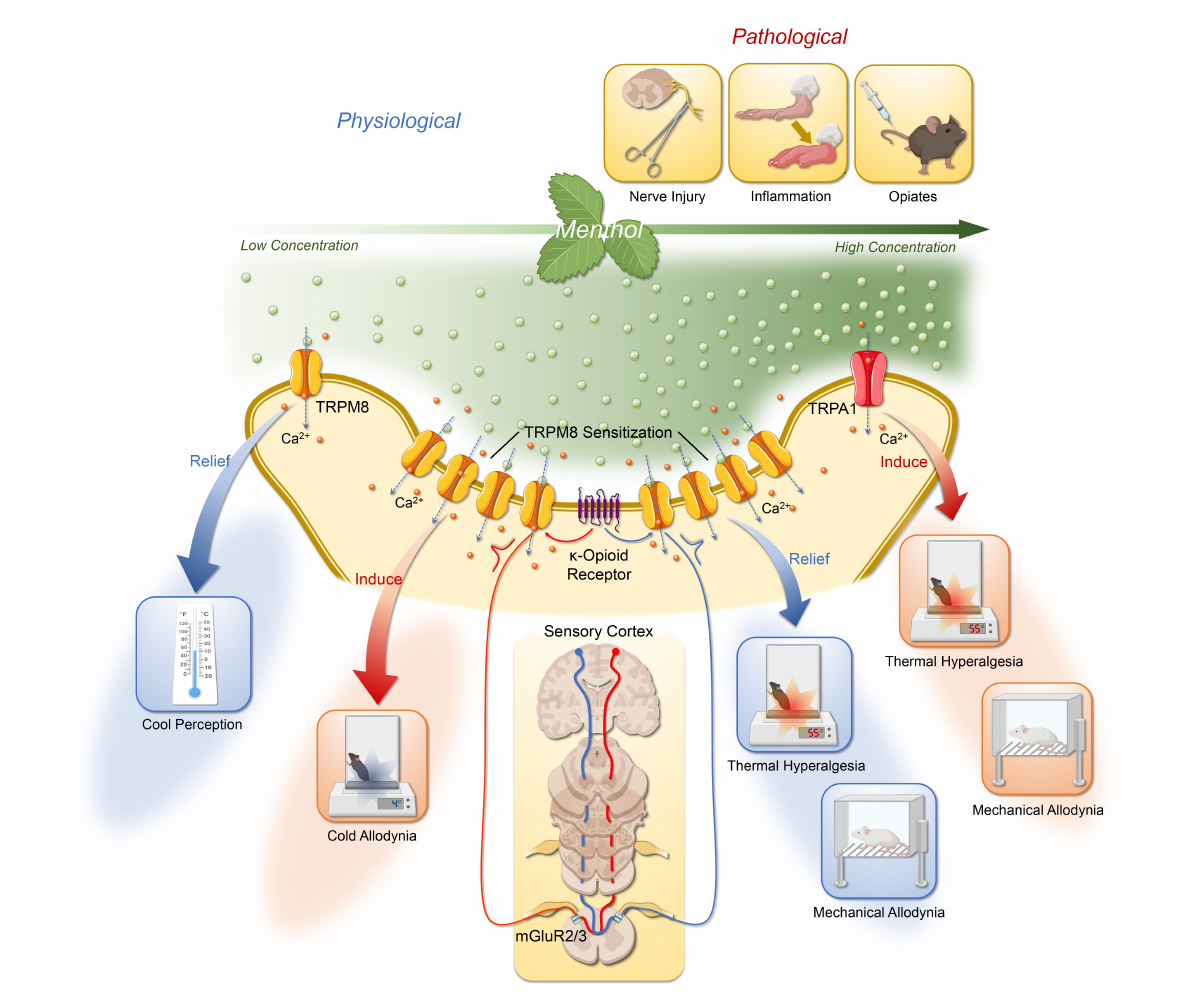
FIGURE1 The possible mechanisms of menthol action on the DRG or trigeminal ganglion via TRPM8 and TRPA1. The effects of menthol are concentration dependent. Low to moderate concentrations of menthol activate TRPM8 in the DRG and trigeminal ganglion to produce a cooling sensation; at higher concentration, menthol could induce cold allodynia, and cold hyperalgesia mediated by TRPM8 sensitization; following nerve injury or chemical stimuli, menthol activates TRPM8 to mediate relief of mechanical allodynia and thermal hyperalgesia. Its analgesic effect is also dependent on the activation of central group II/III mGluR with endogenous κ -opioid signaling pathways. In addition, the thermal and mechanical allodynia of high concentrations of menthol is associated with its activation of TRPA1. Created with